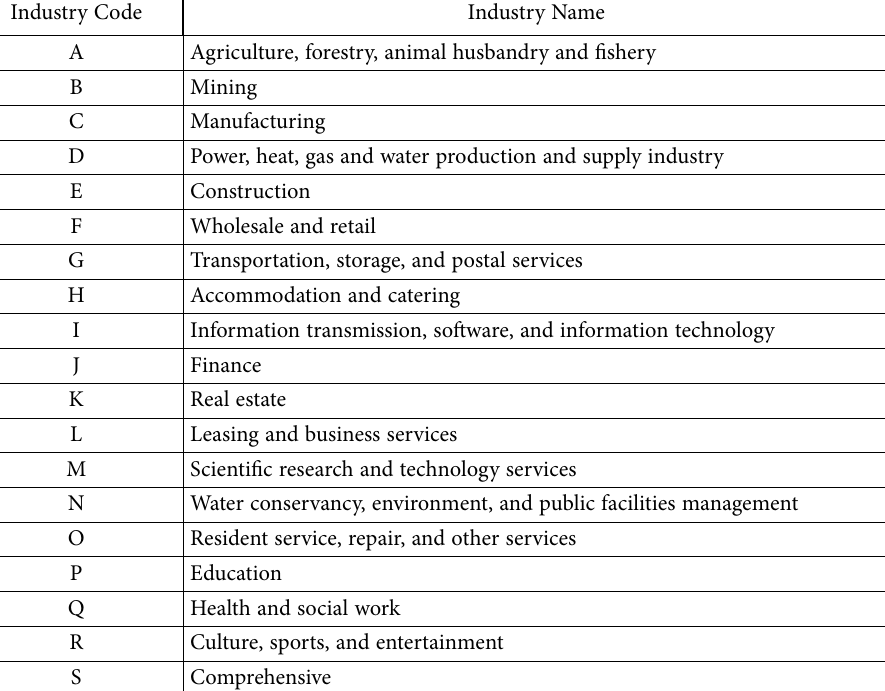
Table 1. Industry classification of CSRC Industry